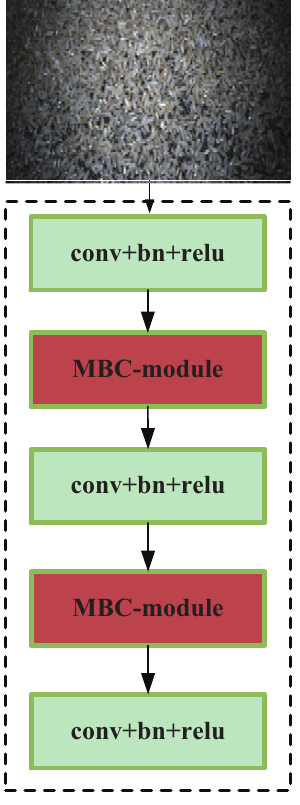
Figure 6. Improved spatial path. It includes three layers of convolution layers and two layers of